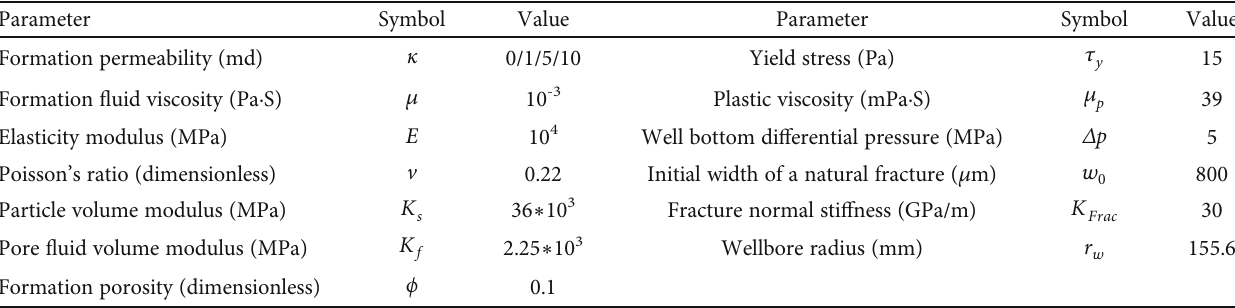
Figure 6: Schematic diagram for solving the dual-system coupling leakage model. Table 1: Calculation